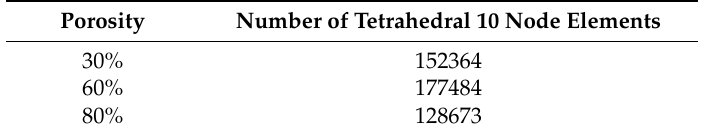
Table 2. Mesh sizes in finite element analysis, for three different porosity levels.